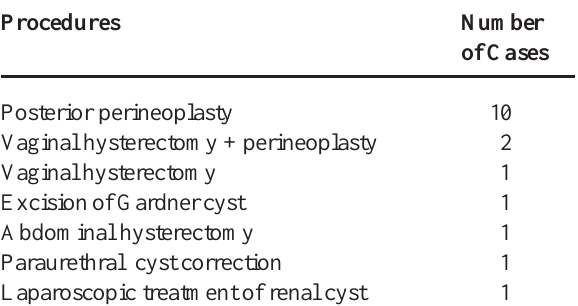
Table 1 – Procedures associated with the pubovaginal sling.